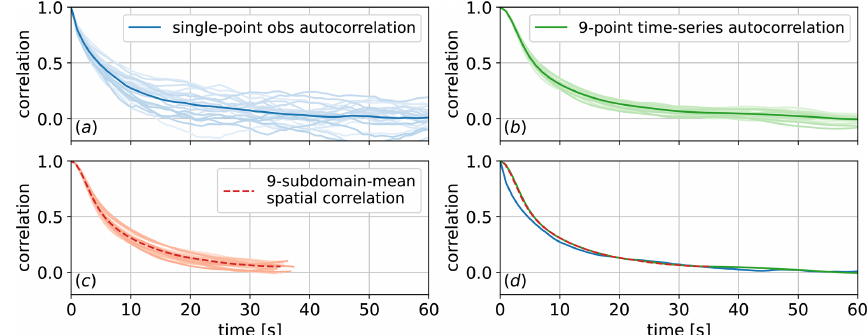
Figure 7. Comparison of spatial correlation and temporal autocorrelation of the streamwise component of the velocity from LES with field data. Each lightly shaded curve represents one 15min interval; the dark-shaded curve is the average of the light curves. (a) Temporal autocorrelation of single-mast observation data obtained at 80m. (b) Temporal autocorrelation of nine virtual meteorological masts from LES. (c) Spatial-correlation results from LES transformed to the time domain. (d) Comparison of the mean curves of each panel.